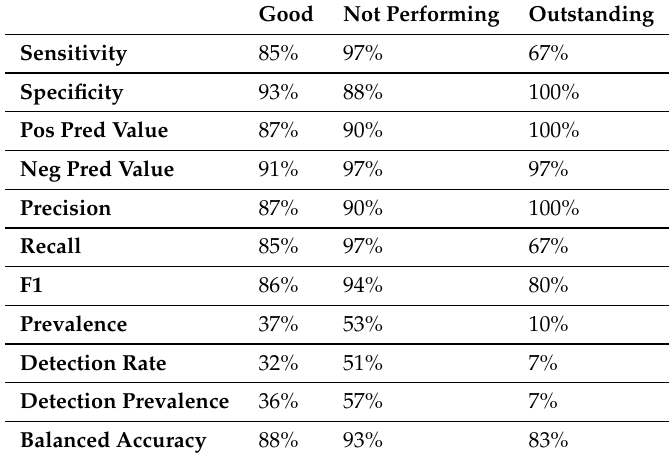
Table 9. Evaluation scores for NB model.